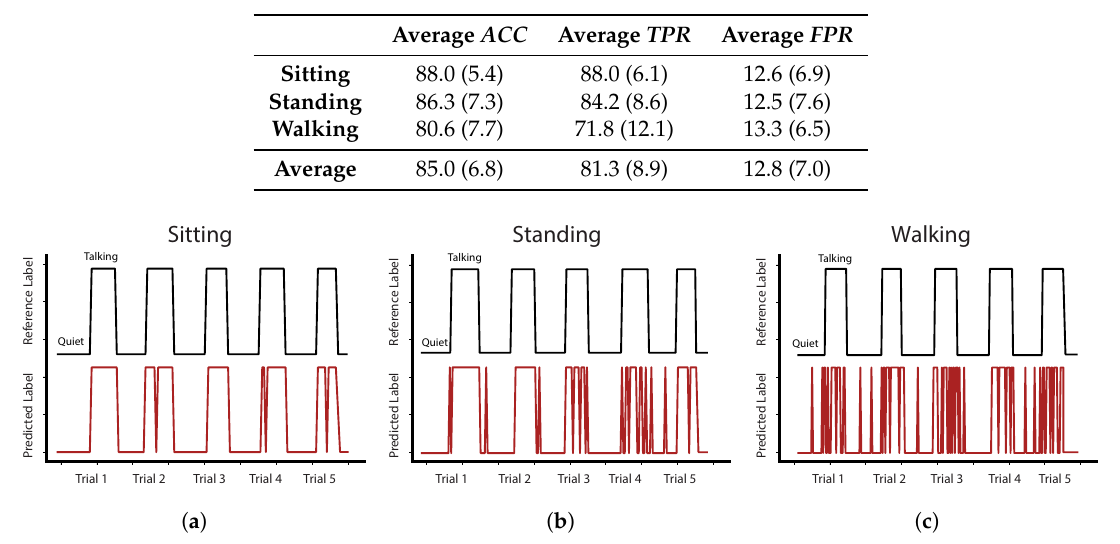
Table 2. Average performance of our algorithm in detecting talking among all participants.